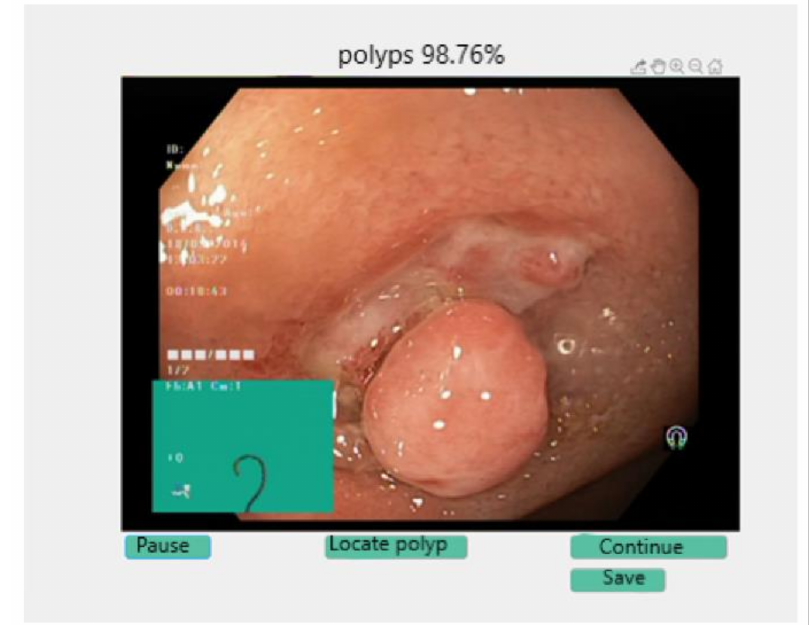
Figure 13. Polyp detected during